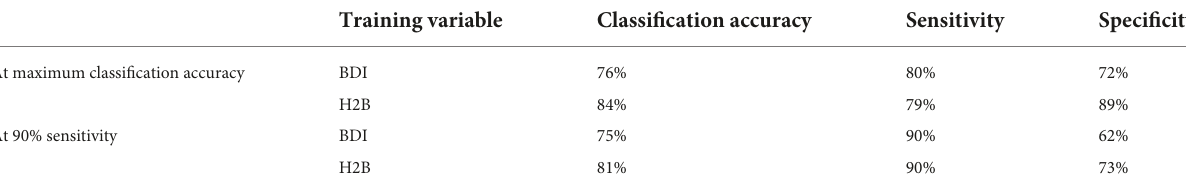
TABLE 6 The accuracy of the classification of depressed and healthy subjects, when H2B or BDI scores were used for training. Training variable Classification